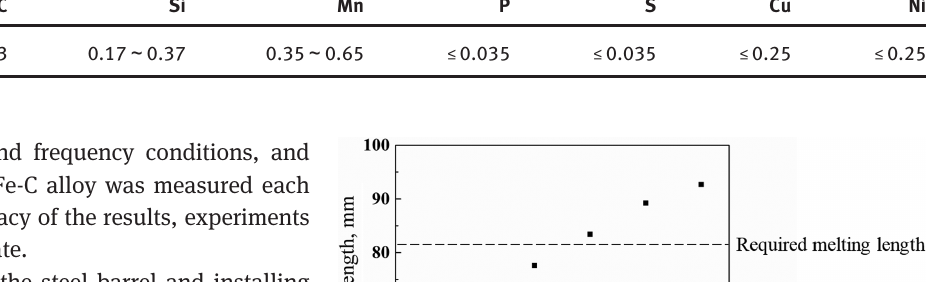
Table 1: Components of the Fe-C alloy particles. Fe-C alloy